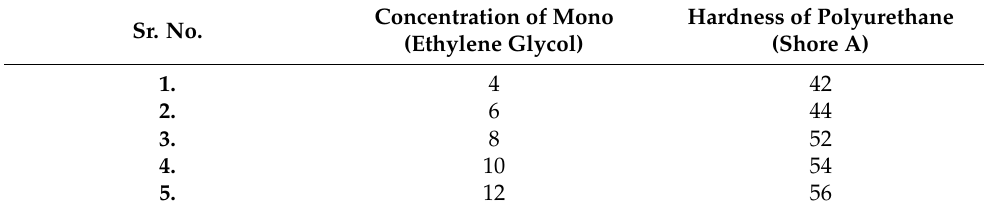
Table 5. Hardness of the polyurethane at different concentrations of monoethylene glycol. Sr.